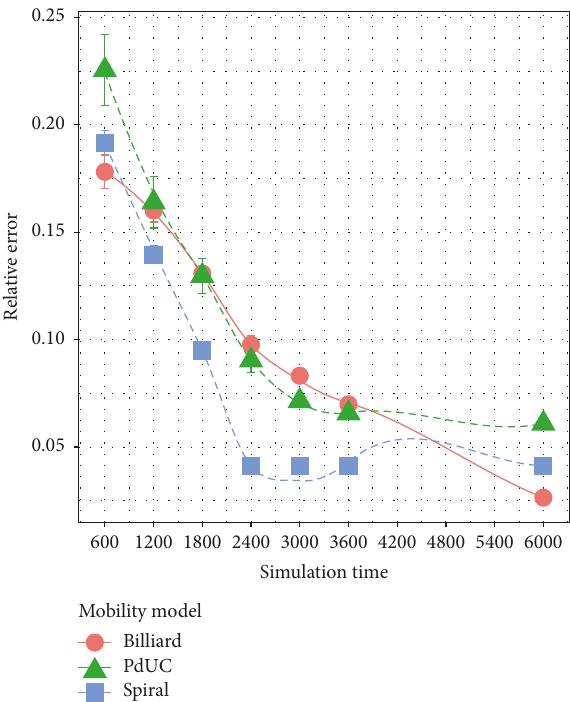
Figure 11: Cumulative Distribution Function of the time spent at covering the complete area for the Billiard, Spiral, and PdUC mobility models.